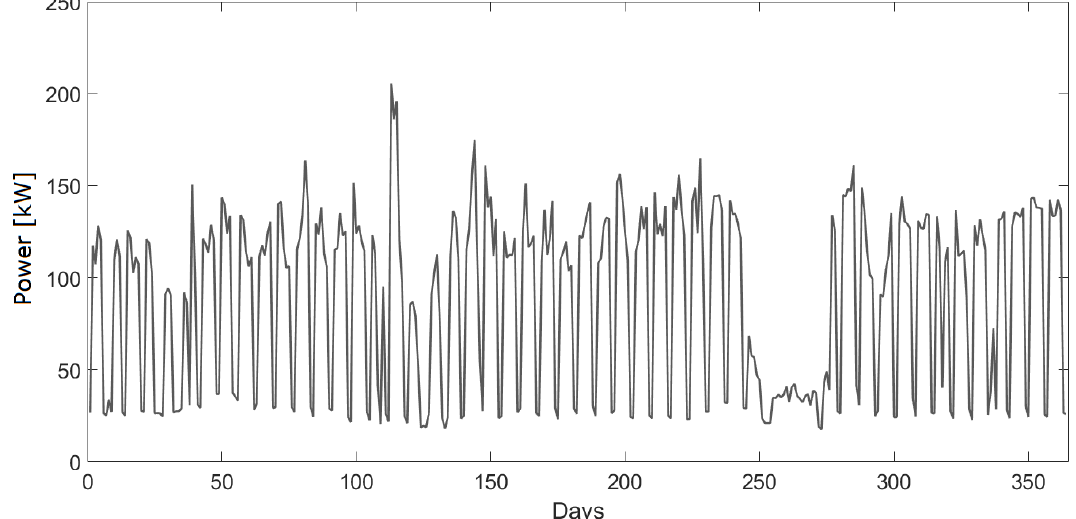
Figure 4. Electricity consumption: Universidad Politécnica Salesiana (9 March 2017–8 March